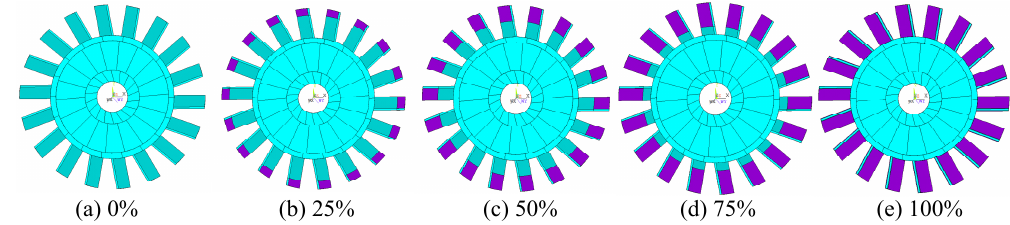
Figure 10. Mistuned blisks with different coating areas. ( a ) 0%; ( b ) 25%; ( c ) 50%; ( d ) 75% and ( e ) 100%.